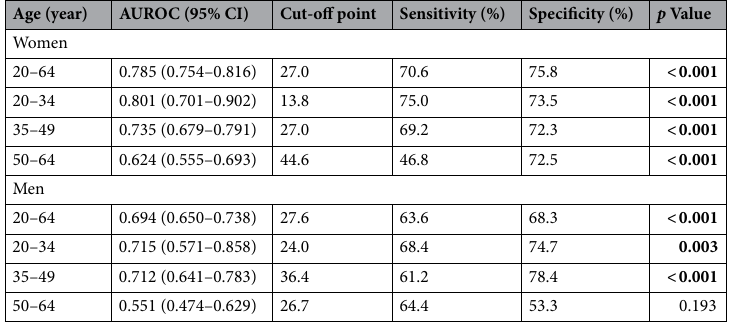
Table 3. The areas under the ROC curve (AUROCs), optimal cut-off values, sensitivities and specificities for LAP associated with hypertension in men and women according to age subgroups. Bold values indicate p < 0.05 AUROC, area under the receiver-operating characteristic curve; CI, confidence